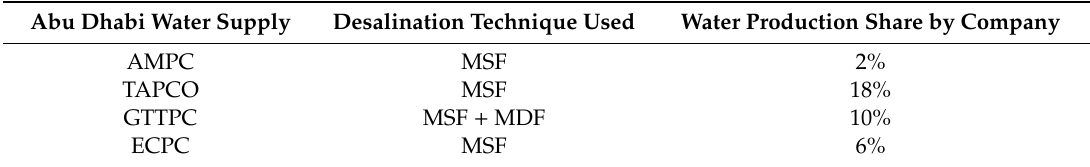
Table 2. Desalination plants serving AD Island [18] .